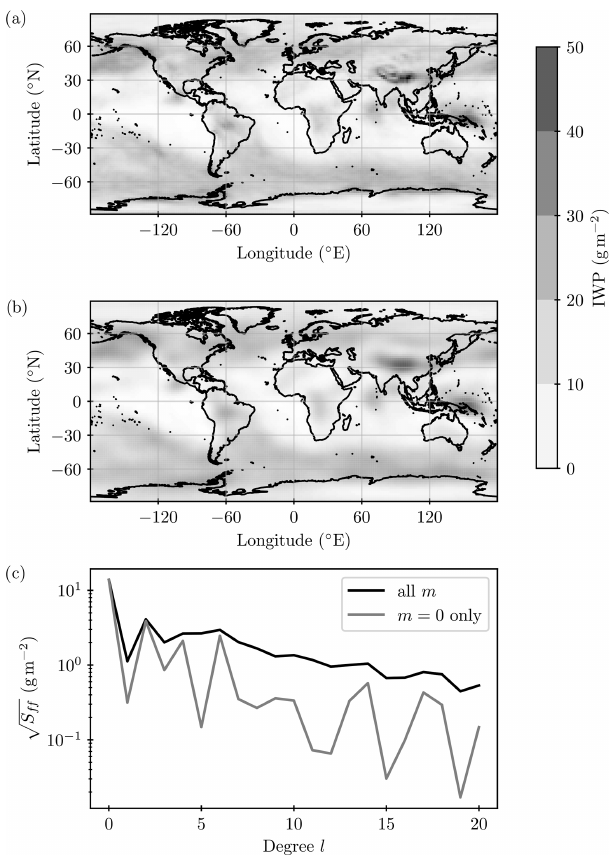
Figure 10. Spherical harmonics expansions for one illustrative PPE member ( η autc ≈ 0 . 87, η accr ≈ 1 . 43, η rime ≈ 0 . 81, η sci ≈ 1 . 89). (a) Global annual mean IWP and (b) expansion of spherical har- monics representing the same data as (a) , generated from the coeffi- cients of the expansion displayed as an angular amplitude spectrum in (c) as a function of the degree l (with m independent solutions, where modes of m = 0 most strongly resemble rotationally sym- metric physical patterns of the Earth system such as a north–south contrast). Note that the variability explained by each degree l in general decreases with increasing l , which allows us to truncate the expansion at the degree l where it represents 95% of the total data variance.